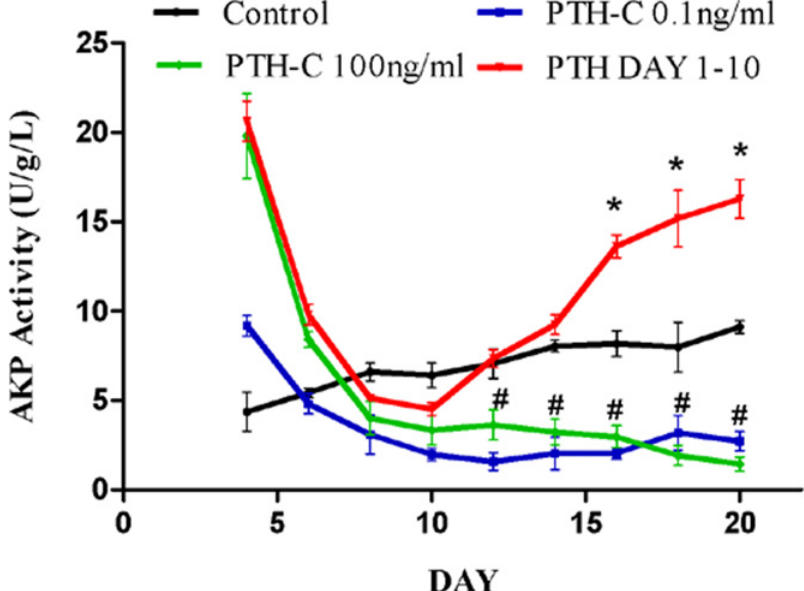
Fig 2. Effects of PTH withdrawal on AKP activity. In control cultures, AKP activity increased with time and reached a plateau after 14 days. In contrast, AKP activity declined from day 4 to day 10 and did not increase over time in the continuous PTH cultures. In the PTH Day 1 – 10 group that was treated with bPTH on days 1 to 10, AKP activity rebounded after withdrawal of bPTH and was significantly higher than controls and continuously bPTH-treated cells from day 16. AKP activity did not fully recover until day 20. * , # Significantly different compared to control at the same time point, P < 0.05.